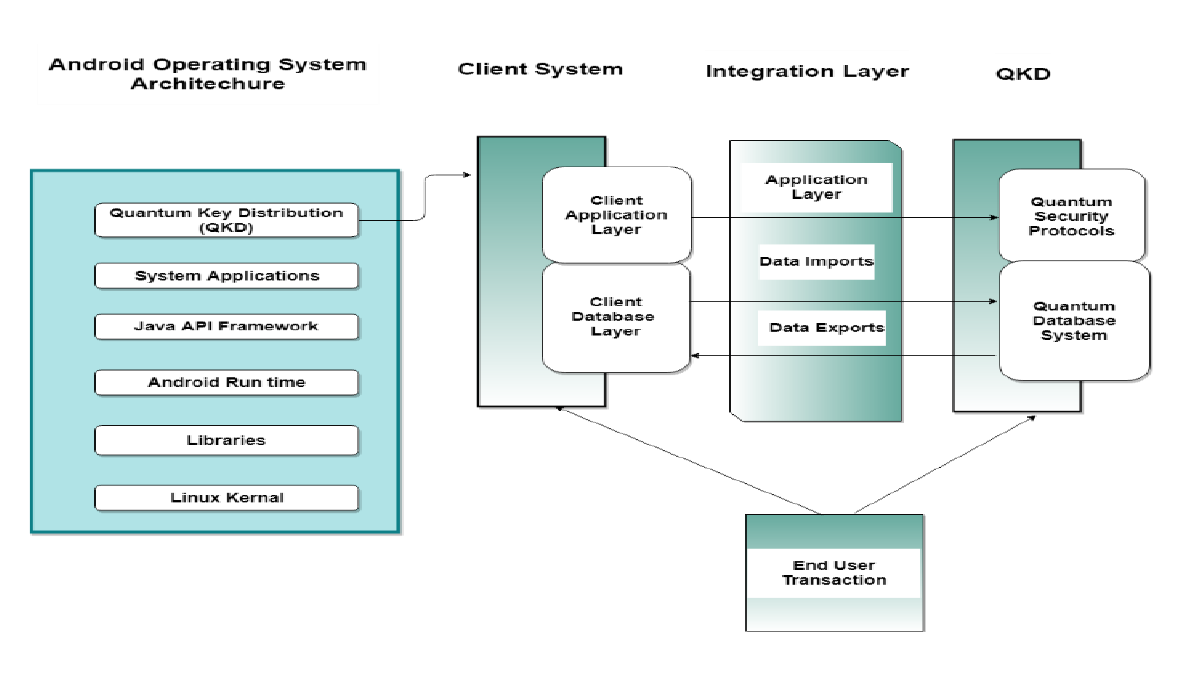
Figure 3. Proposed Architecture of the Android System .